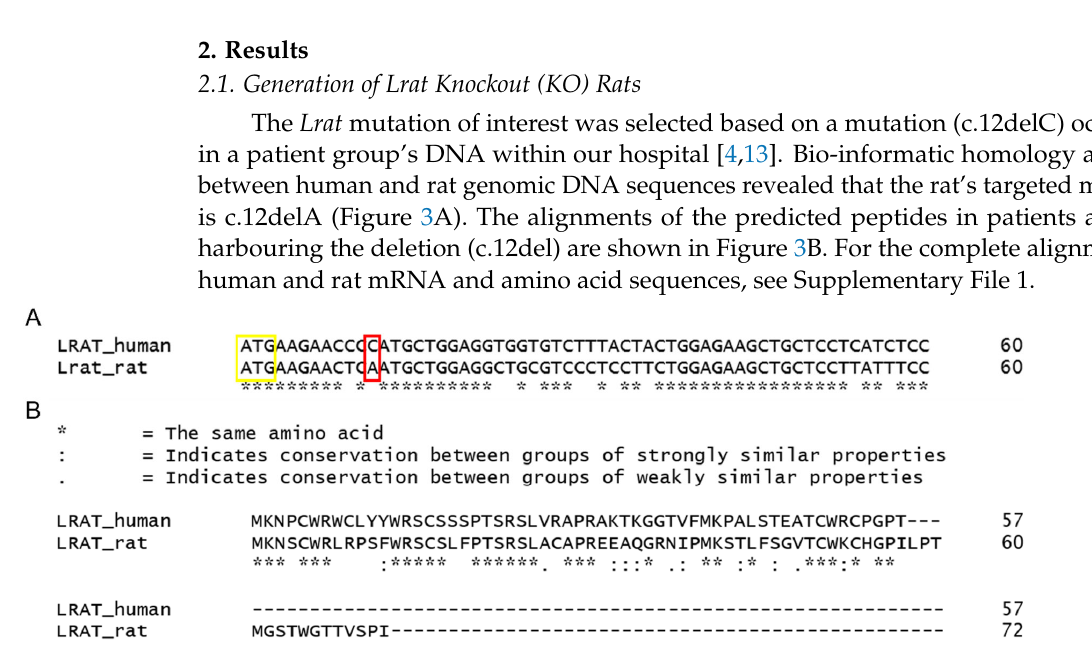
Figure 3. Alignment of the human and rat genomic DNA and protein sequences. ( A ): Alignment of the first 60 nucleotides of the LRAT and Lrat ORF starting with the start codon (indicated by the yellow box). The red box indicates the nucleotide that is deleted in patients (c.12delC) and the rat equivalent (c.12delA). ( B ): Alignment of the predicted resulting peptide in patients and rats harboring the deletion (c.12del). The single nucleotide deletion in the genomic DNA causes a frameshift from the fifth amino acid onwards and a truncated protein in both humans (57 amino acids) and rats (72 amino acids).